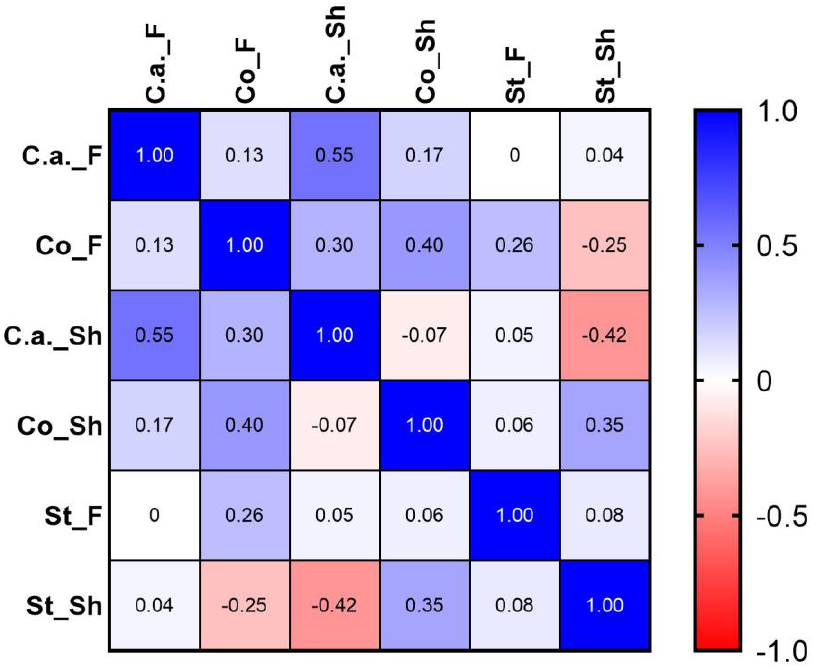
Figure 6. Spearman’s rank correlation coefficients obtained from microbiota analyses results (species level) in the two different areas: F forehead area; Sh shoulder area: C.a = Cutibacterium acnes ; Co = Corynebacterium sp.; St = Staphylococcus sp.